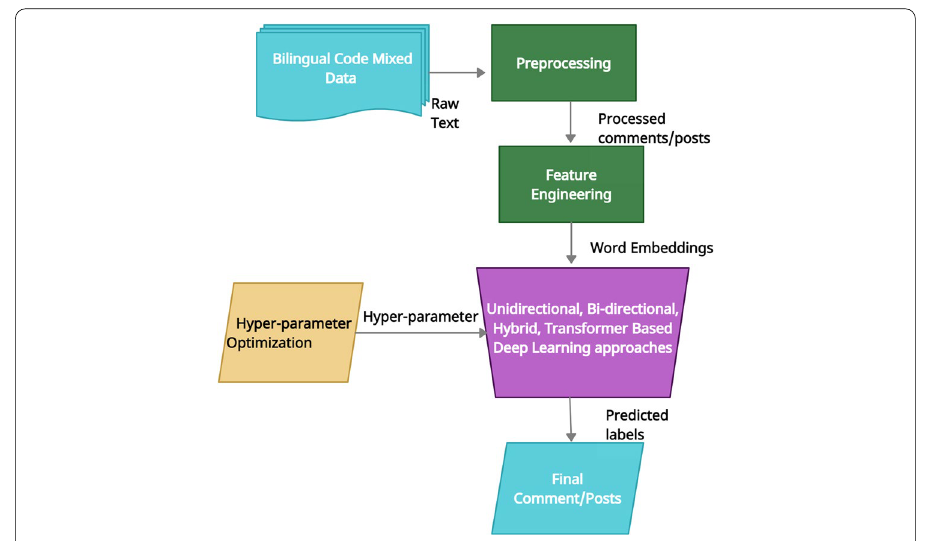
Fig. 1 Flow diagram of the proposed